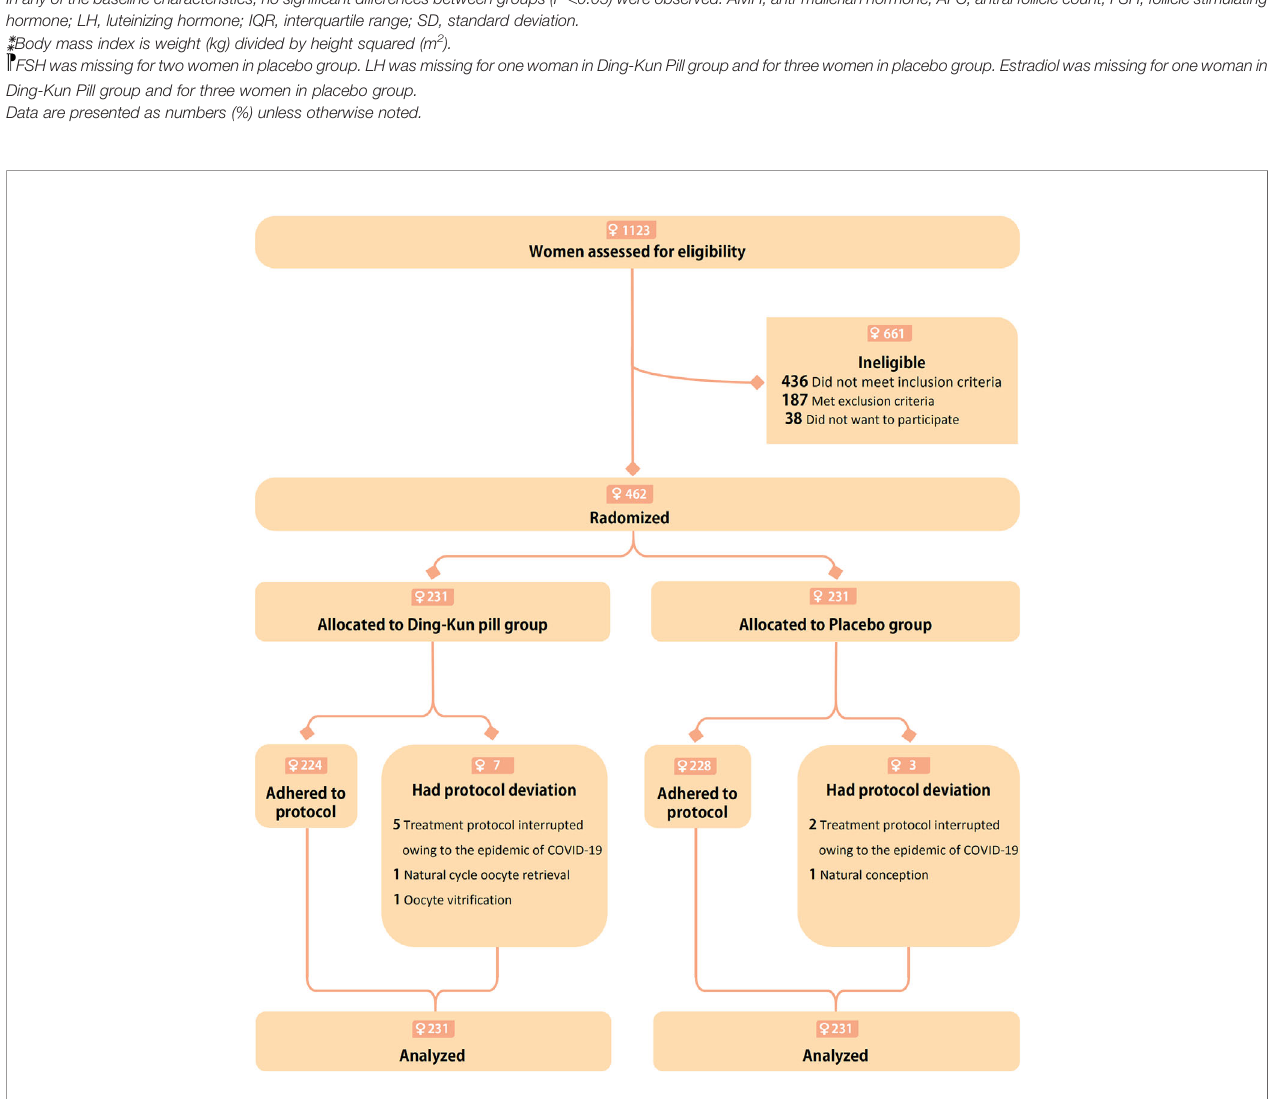
Frontiers in Endocrinology |